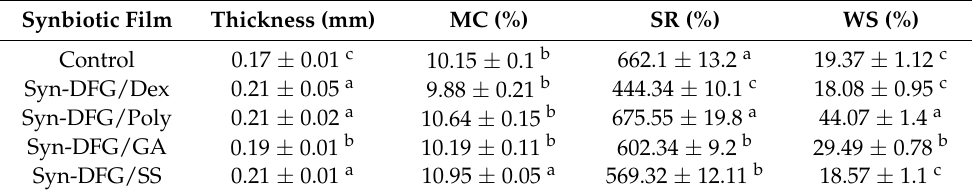
Table 4. Physicochemical properties of synbiotic edible films. Synbiotic